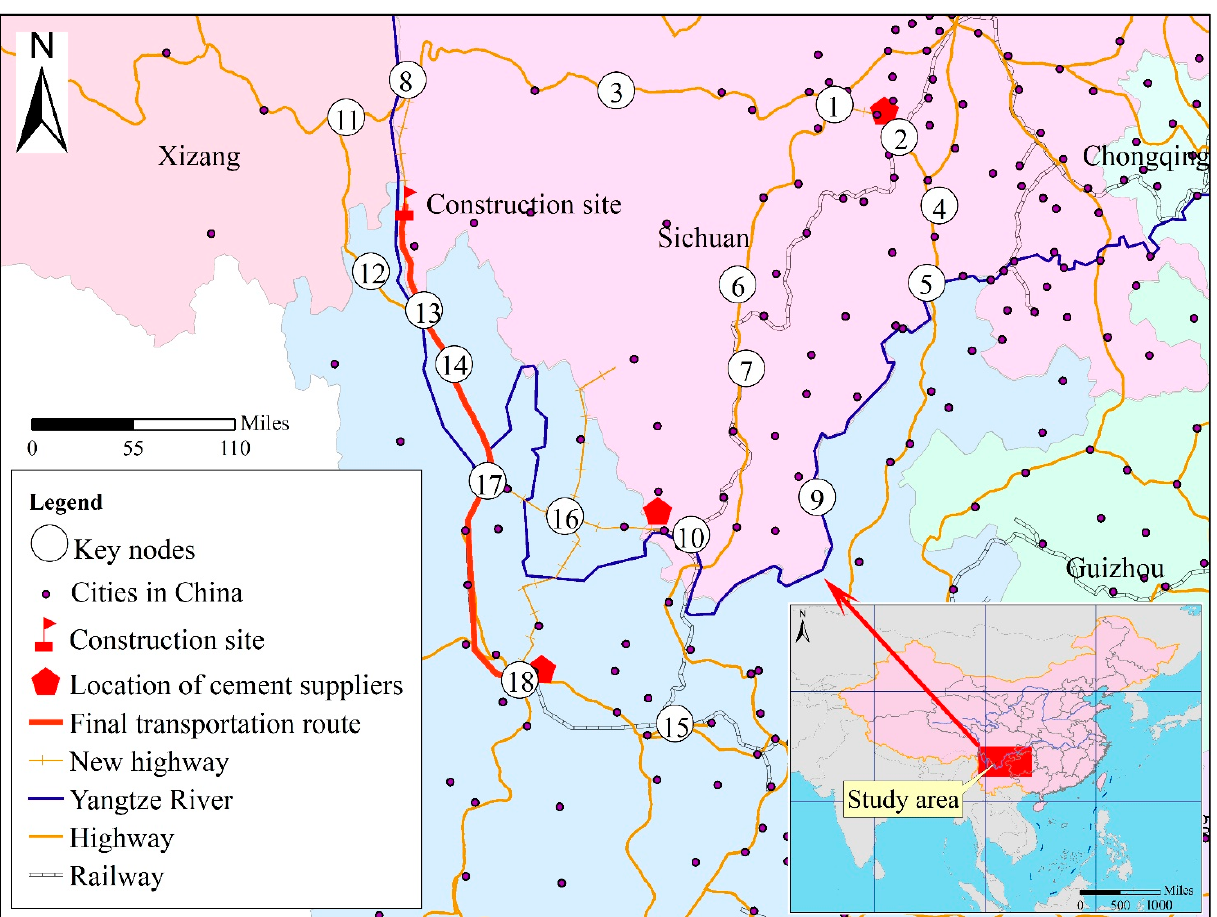
Figure 5. The case’s transportation network and cement transportation scheme.